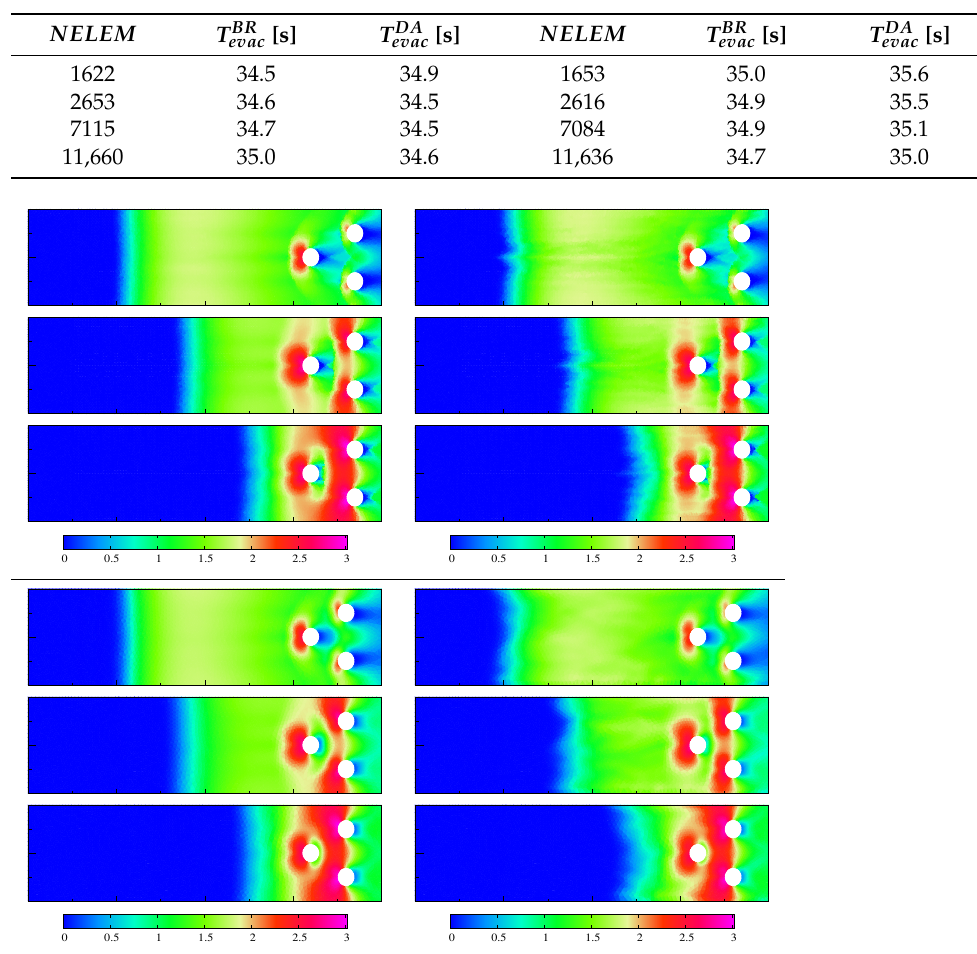
Table 2. Domain with three obstacles, FV (left) and FV-DG (right)-Comparison of computations on the series of meshes, NELEM = # T h , T BR evac = evacuation time with Bornemann-Rasch algorithm, T DA evac = evacuation time with Dijkstra’s algorithm.